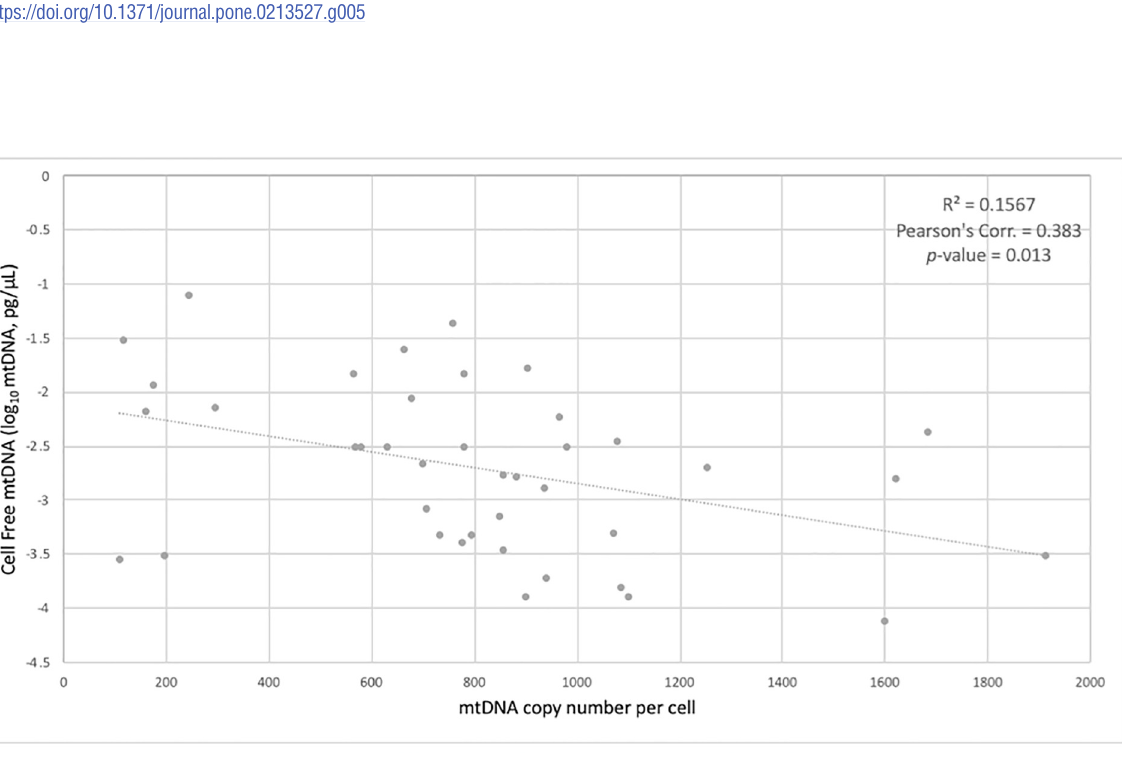
PLOS ONE | https://doi.org/10.1371/journal.pone.0213527 March 12,